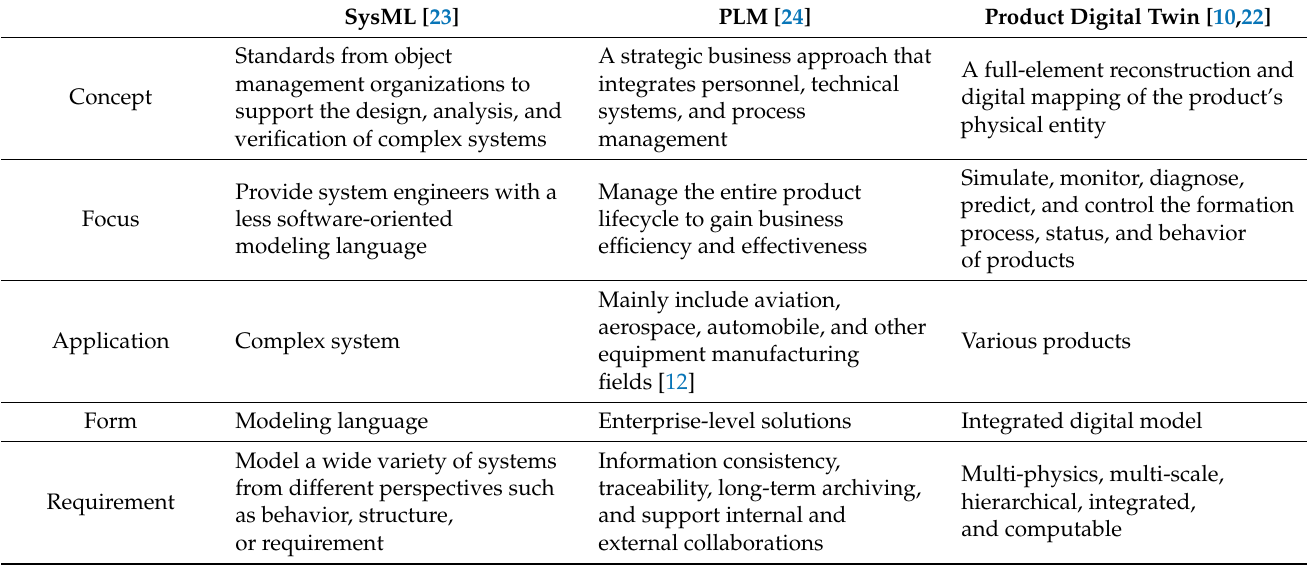
Table 1. Comparison of product data integration and modeling methods.